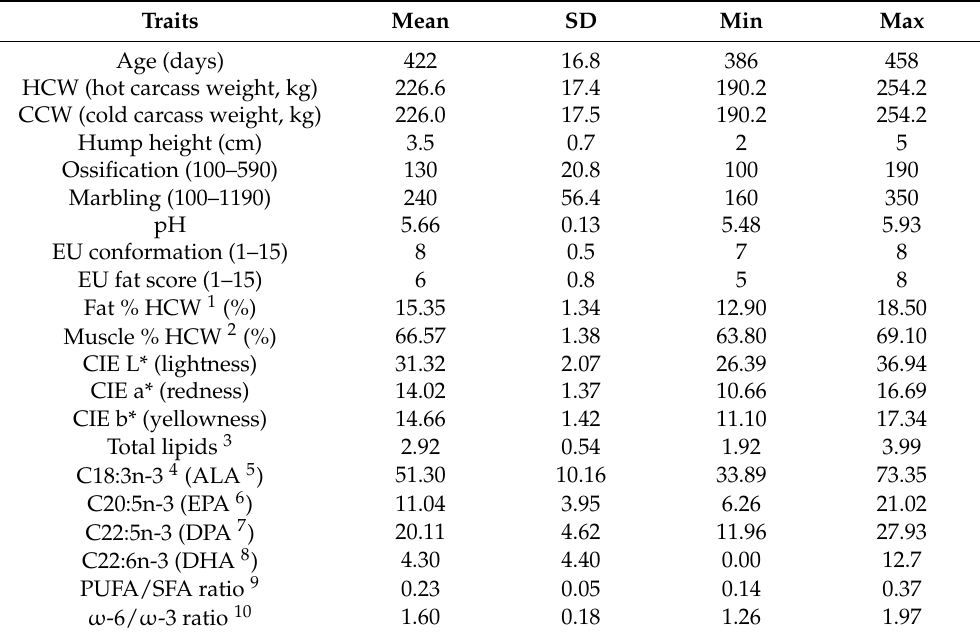
Table 1. Unadjusted means, standard deviations, minimum and maximum values for animal age, carcass traits, meat pH, color, lipid content, FA content and FA index. Traits